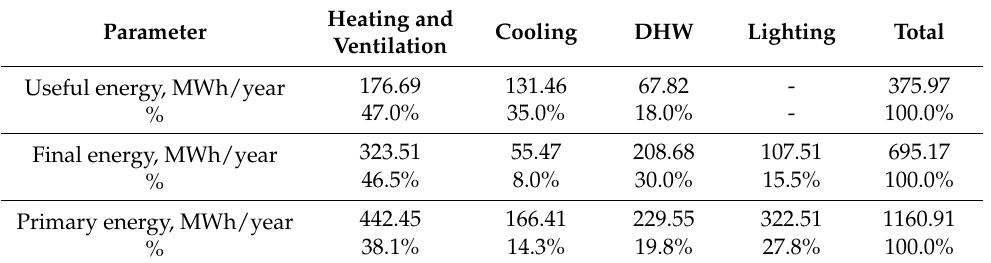
Table 8. Heat demand calculations after replacing air handling units and water equipment—variant 2.